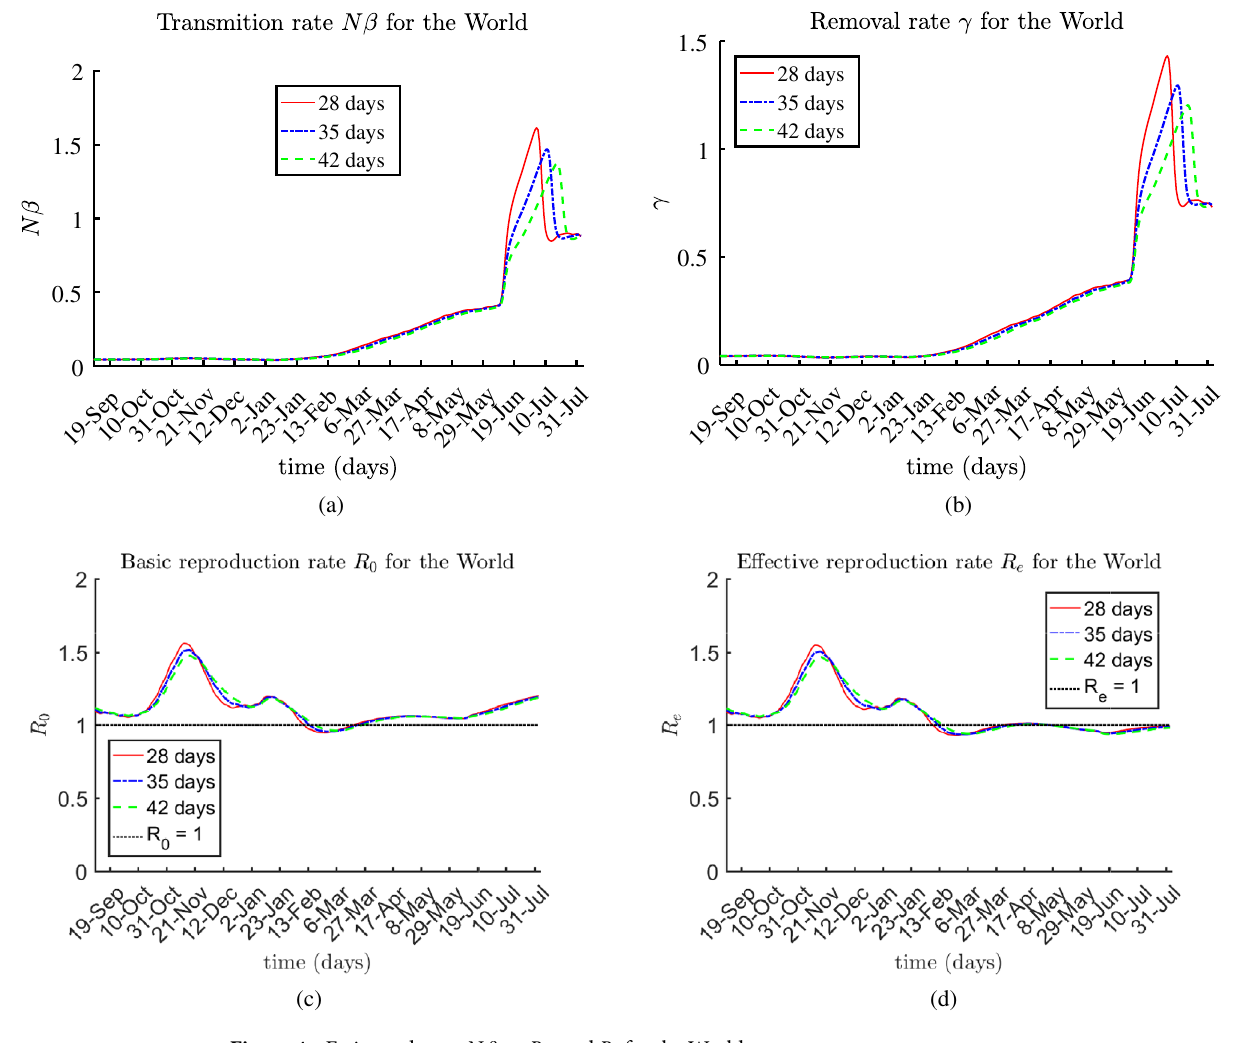
Figure 4. Estimated rates N β , γ , R 0 , and R e for the